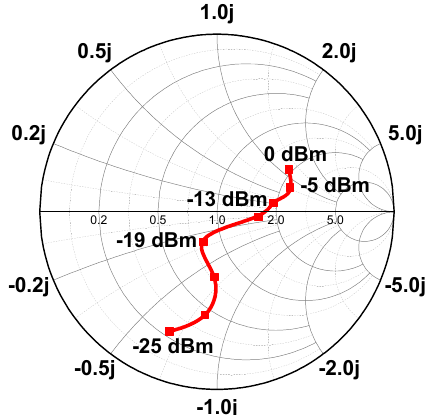
Figure 10. Input impedance of the RF–DC converter according to the RF input power.